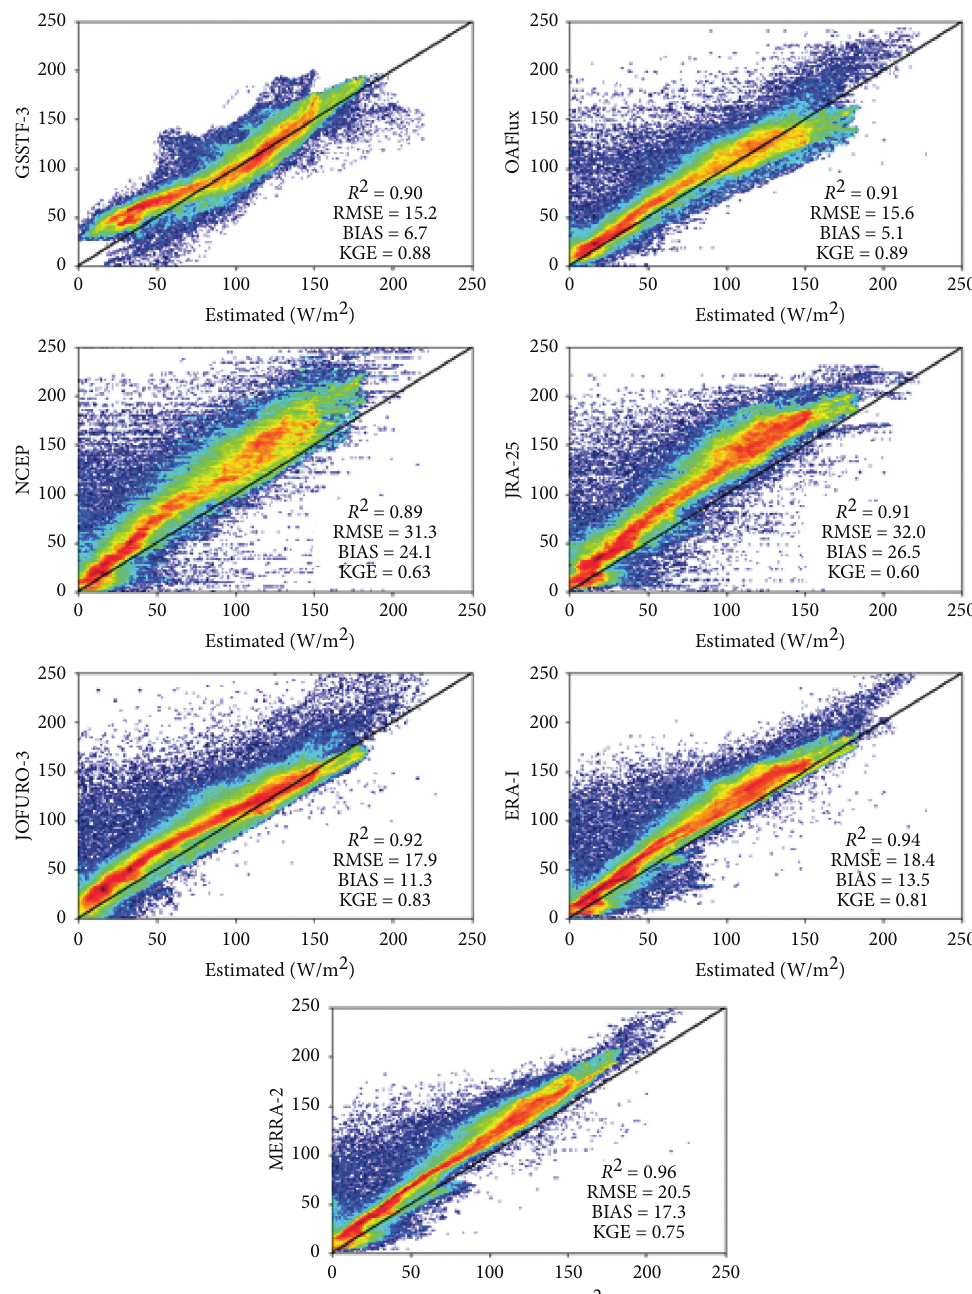
Figure 7: Scatter plots between our estimated LHF and other LHF products at all